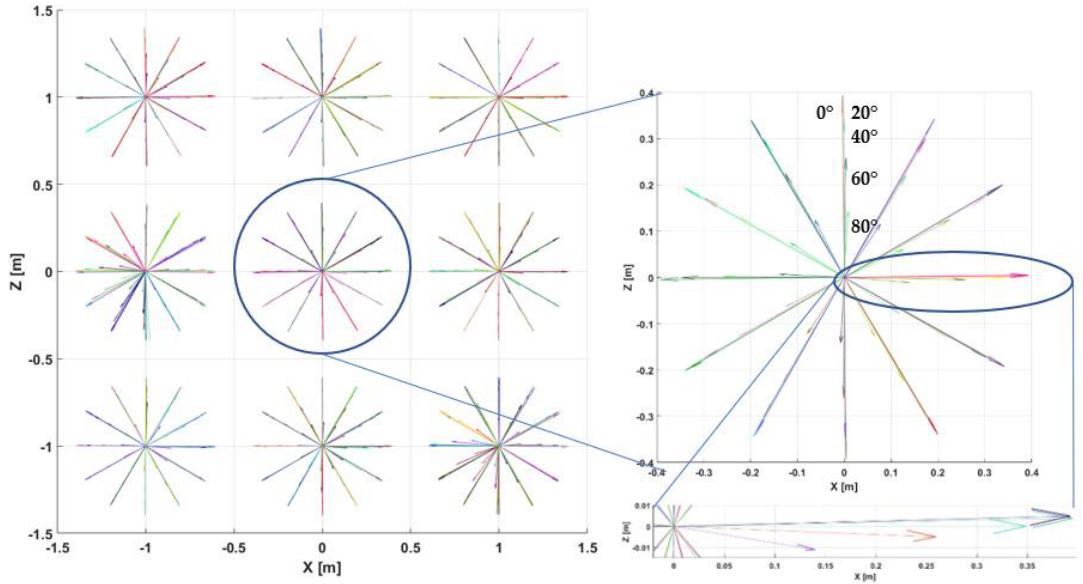
Figure 9. Vectors indicating the direction in which the launcher was facing during the measurements (top view).